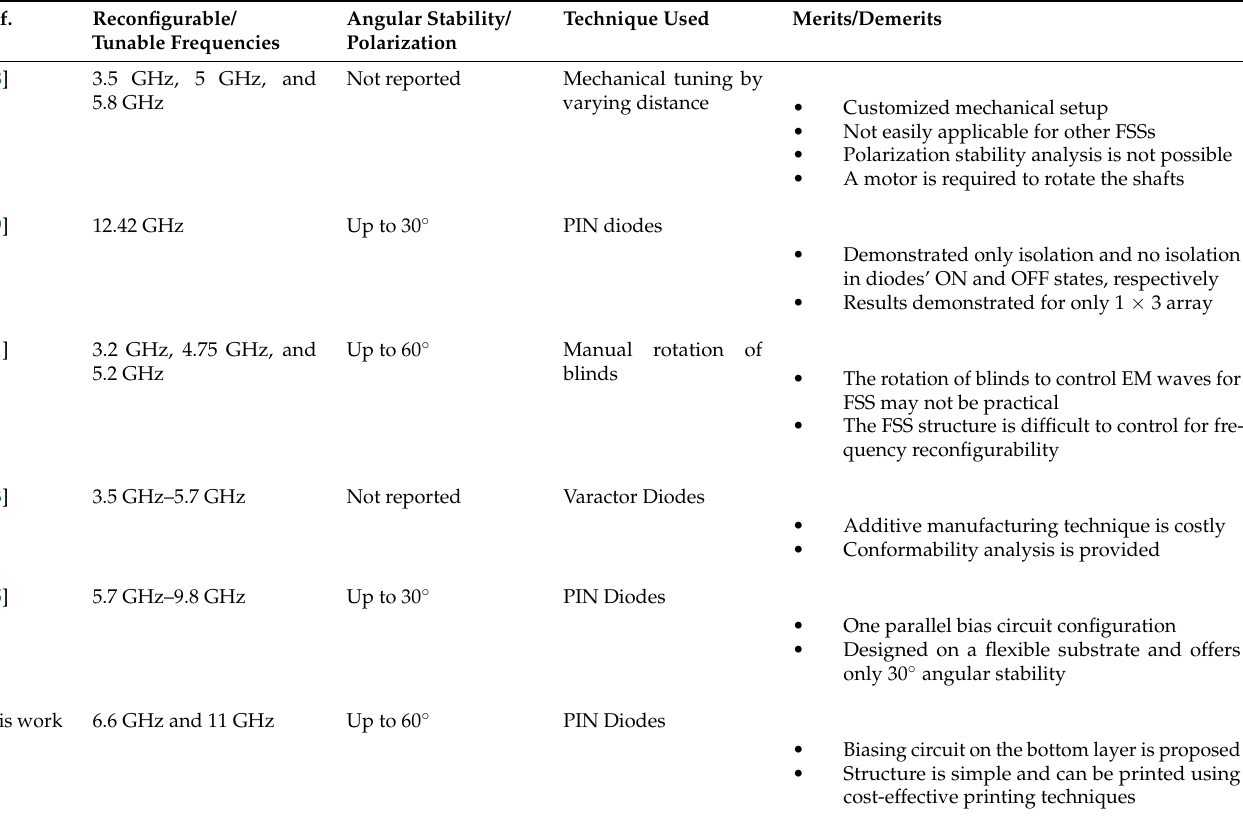
Table 2. Performance comparison with previously published